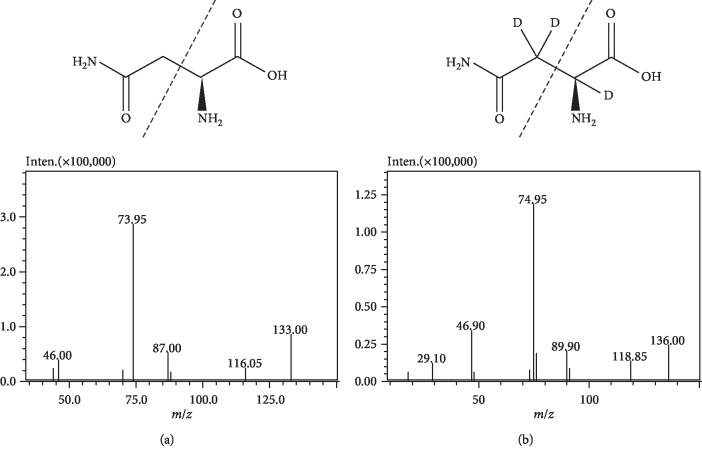
Molecular structure and product ion spectra of ASN (a) and ASN-D3 (b).